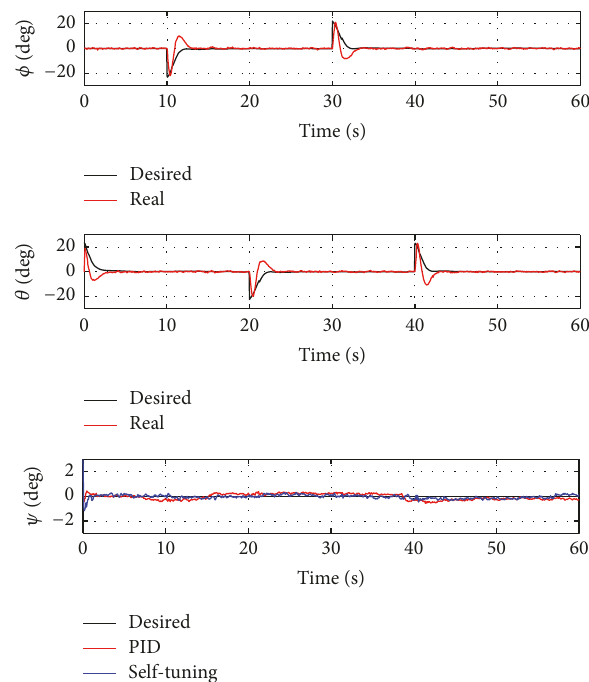
Figure 13: Response curves of quadrotor UAV attitude (𝜙,𝜃,𝜓) .